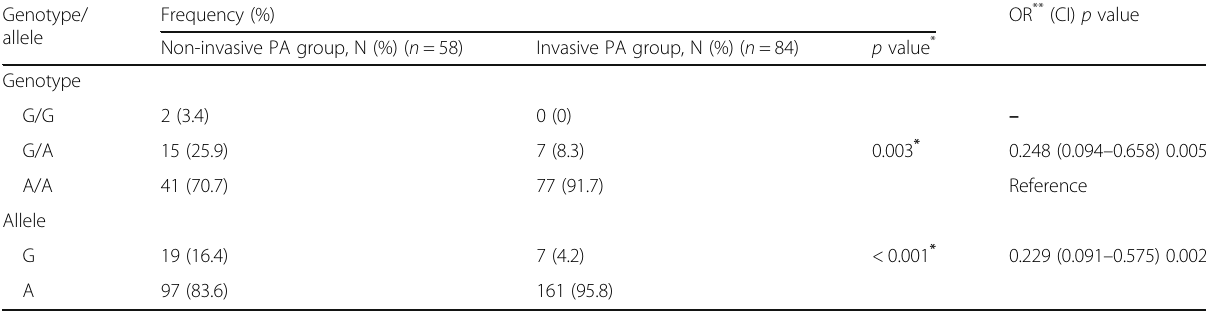
Table 4 The frequency of genotypes and alleles of rs3740051 in patients with non-invasive PA and invasive PA Genotype/ allele